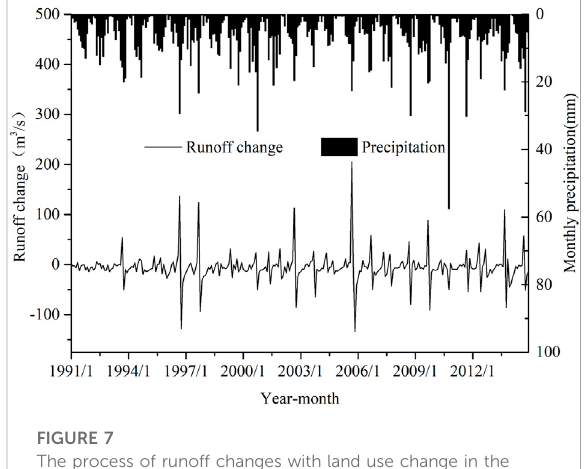
FIGURE 9 The annual change of maximum and minimum temperature in the Wanquan river basin.